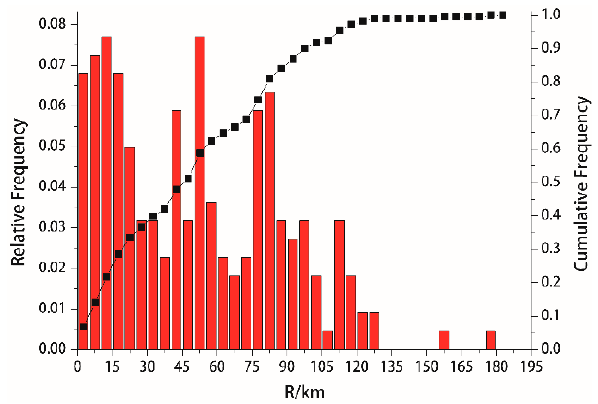
Figure 1. The relative frequency distribution of the closest distance-to-fault for all the 221 sets of seismic signals in the Chi-Chi event collected from the virtual data center (VDC).